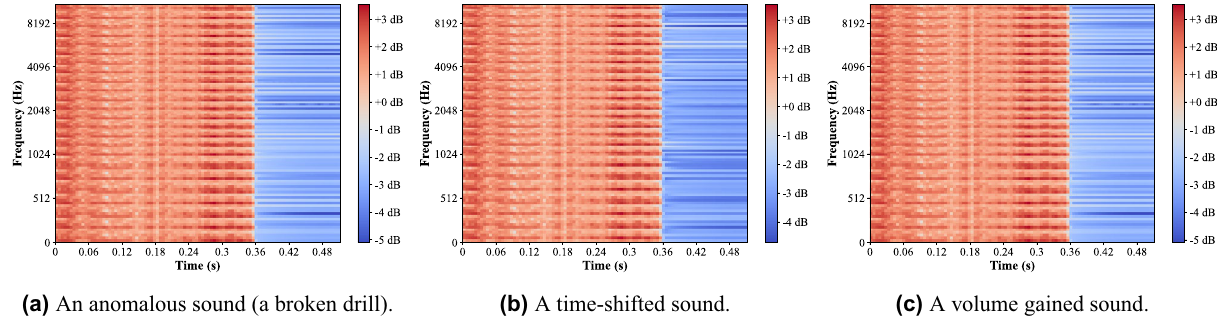
Figure 4. Log-Mel spectrograms of an original anomalous sound, the augmented sounds using time-shifting and volume